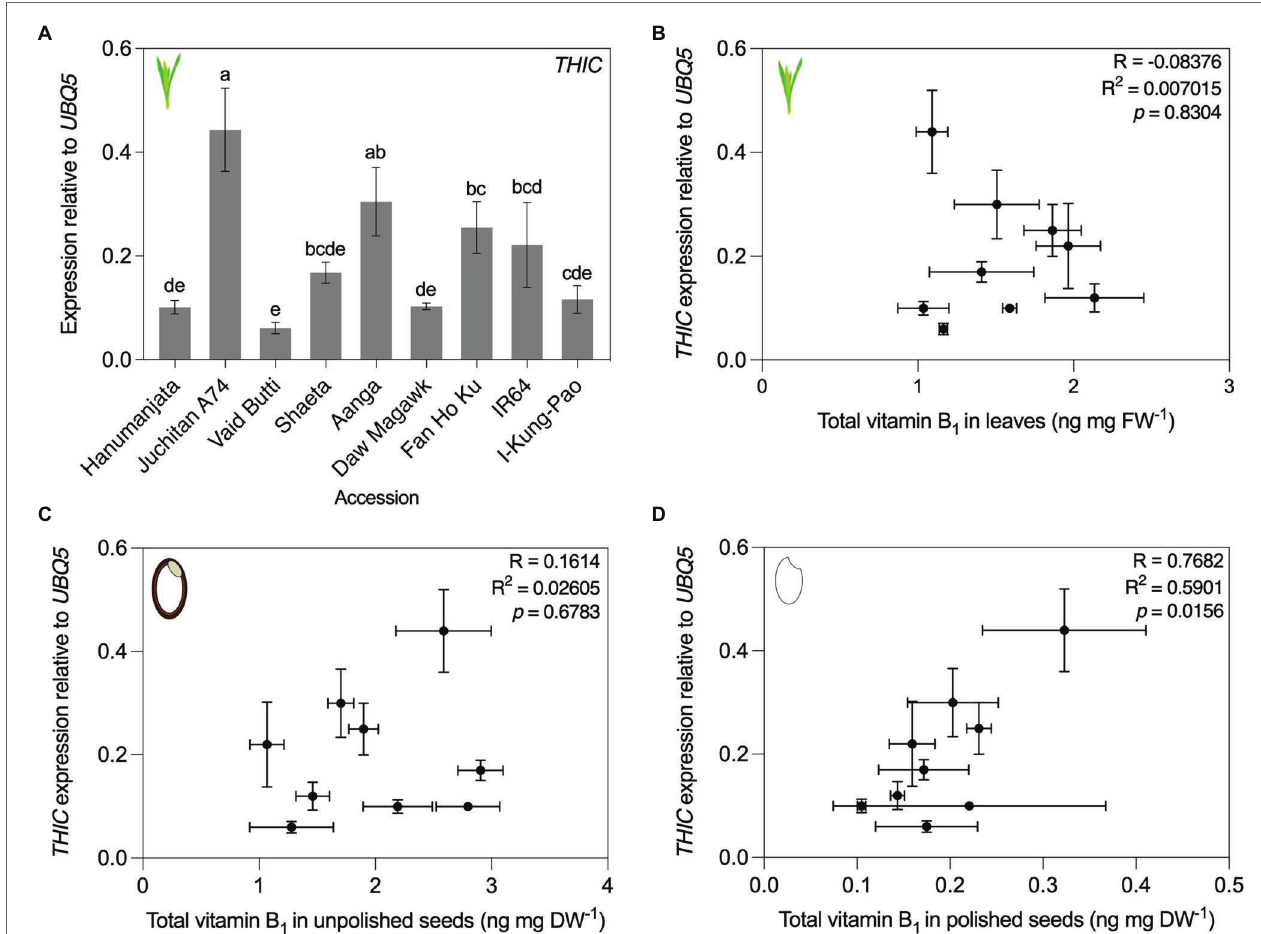
FIGURE 6 | THIC expression in leaves and correlation of accessions with contrasting vitamin B 1 contents. (A) RNA was isolated from plant material used in Figure 4B for qRT-PCR assay of THIC expression. Expression was normalized to UBQ5 and data are the mean ± standard deviation of n = 3 biological replicates. The effect of accession on gene expression was determined by one-way ANOVA ( α = 0.05) with multiple comparisons and Tukey’s post-hoc test. Statistically significant differences between accessions are denoted by different letters. Accessions are ordered according to leaf total vitamin B 1 content as determined in Figure 4B . (B–D) Correlation of THIC gene expression from panel (A) with leaf (B) total vitamin B 1 contents in Figure 4B by Pearson’s correlation coefficient test ( p < 0.05), unpolished seed from Figure 4C (C) , and polished seed total vitamin B 1 contents from Figure 4D (D)